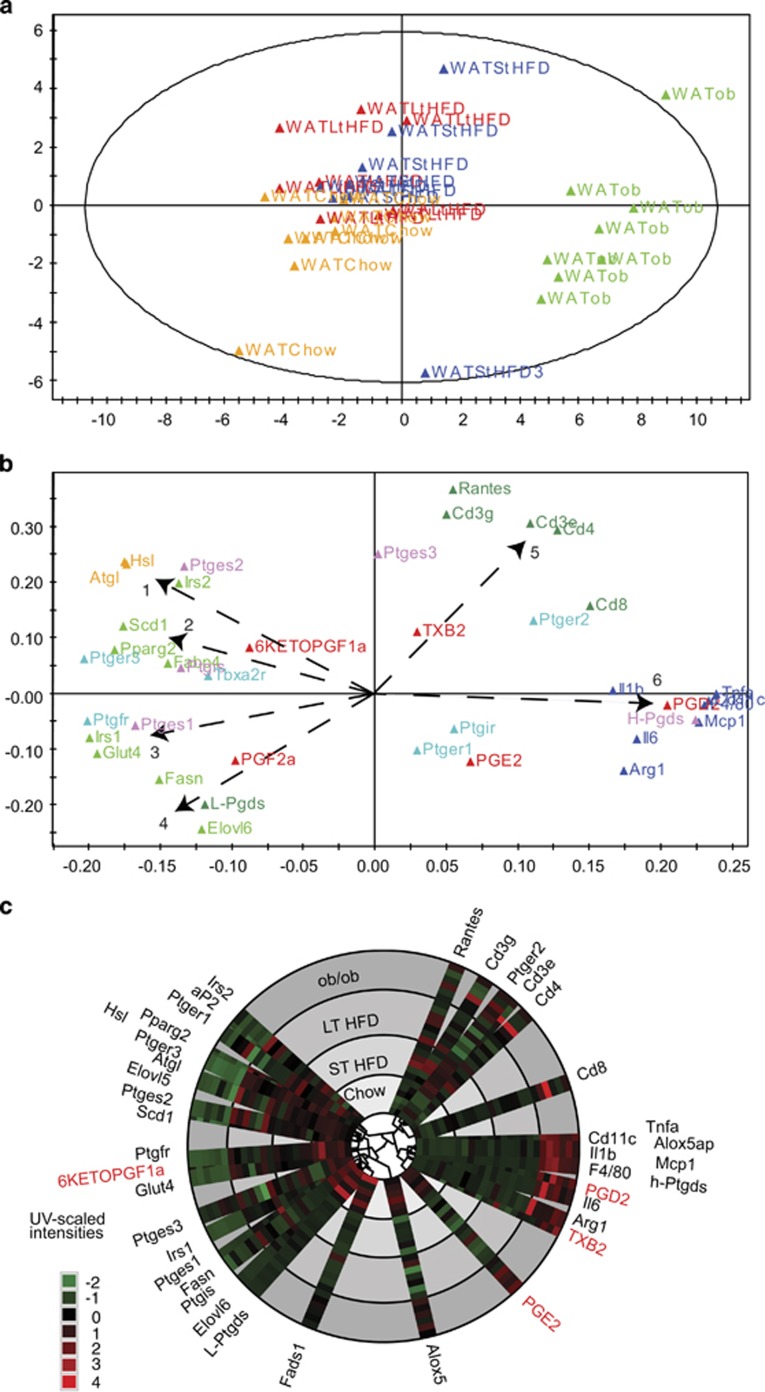
Clustering of prostaglandins with markers of biological processes. (a) PCA plot showing separation of WT, HFD fed and ob/ob mice based on prostaglandins and gene expression markers. (b) Loadings plot for PCA analysis shown above. Arrows show directions of contributions by: (1) Lipolytic markers, (2) adipogenic markers, (3) Insulin-sensitivity markers, (4) De novo lipogenic markers, (5) T-cell markers, and (6) Macrophage markers. (c) NEATmaps of transcriptomic and prostaglandin data. N=8 mice per group, for PCA analyses. N=6 mice per group for clustering analyses. C57Bl/6 females, 16 weeks of age.